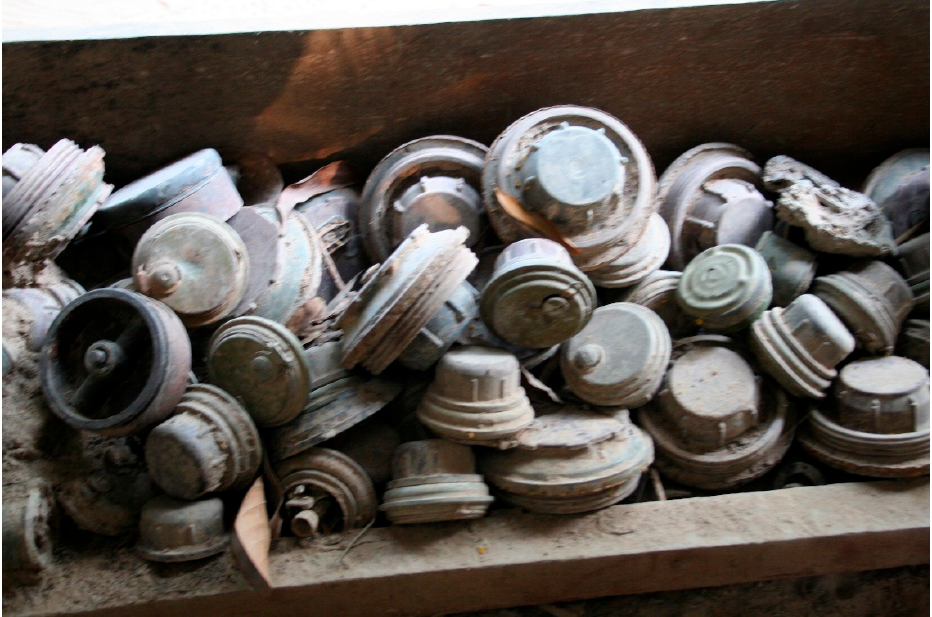
Figure 1. Landmines limit access to some areas frequented by desert locusts; photo credit Neil Rickards.